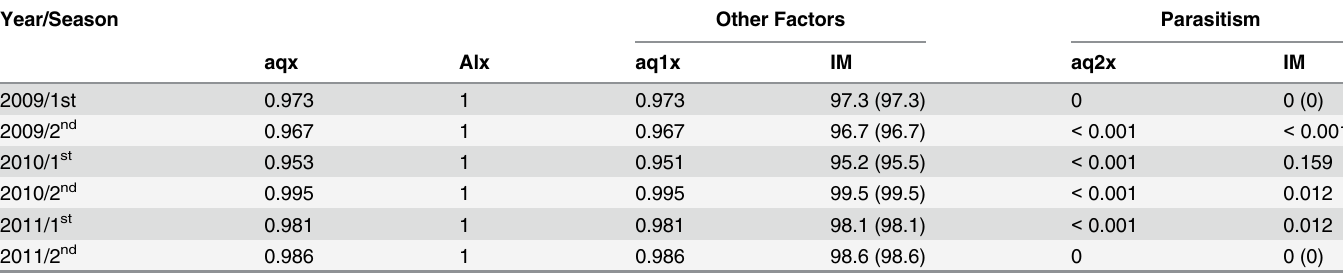
Table 4. Multiple decrement life table and percentage irreplaceable mortality for early larval stage of FAW in maize fields. Year/Season Other Factors